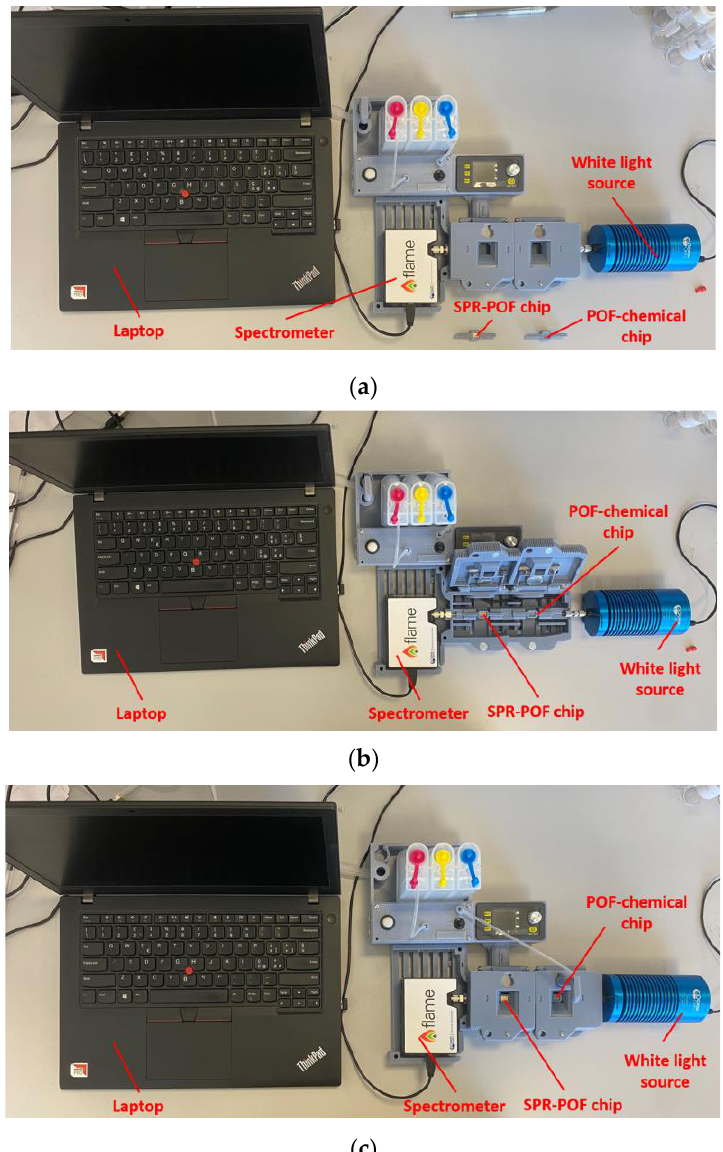
Figure 3. Pictures of the experimental setup based on a custom holder: ( a ) without sensor chips in the holder, ( b ) with hatches open and sensor chips placed in the holder, and ( c ) with sensor chips in the 3D-printed holder and hatches closed.